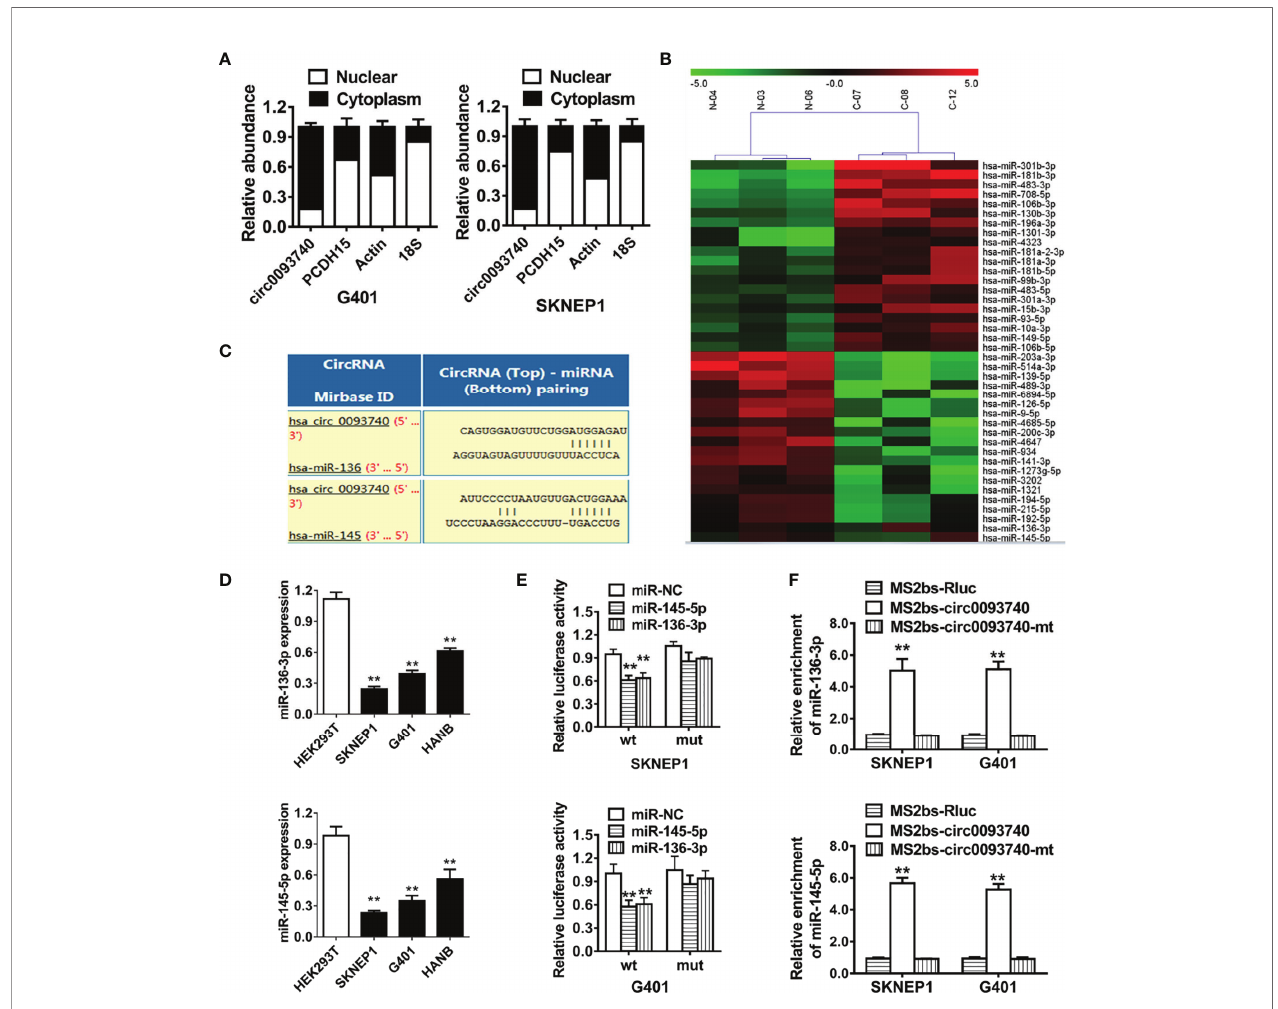
FIGURE 4 | circ0093740 serves as a sponge of miR-136/145 in Wilms tumor. (A) 18S, ACTIN, circ0093740 and PCDH15 expression in nuclear and cytoplasmic fractions were analyzed by RT-qPCR. (B) miRNA sequencing on three pairs of circ0093740 overexpression and vector samples was conducted in SKNEP1 cell line. (C) Predicted binding sites of miR-136/145 within the circ0093740 sequence. (D) miR-136 and miR-145 expression in Wilms tumor cell lines compared to HEK293T. (E) Luciferase reporter assay was conducted in SKNEP1 and G401 Wilms tumor cell. miR-136 and miR-145 mimics were cotransfected with circ0093740 wild type/mutant luciferase reporter. (F) MS2-based RIP assay transfected with MS2bs-circ0093740 vector, MS2bs-circ0093740-mt vector or Rluc control vector. **p <